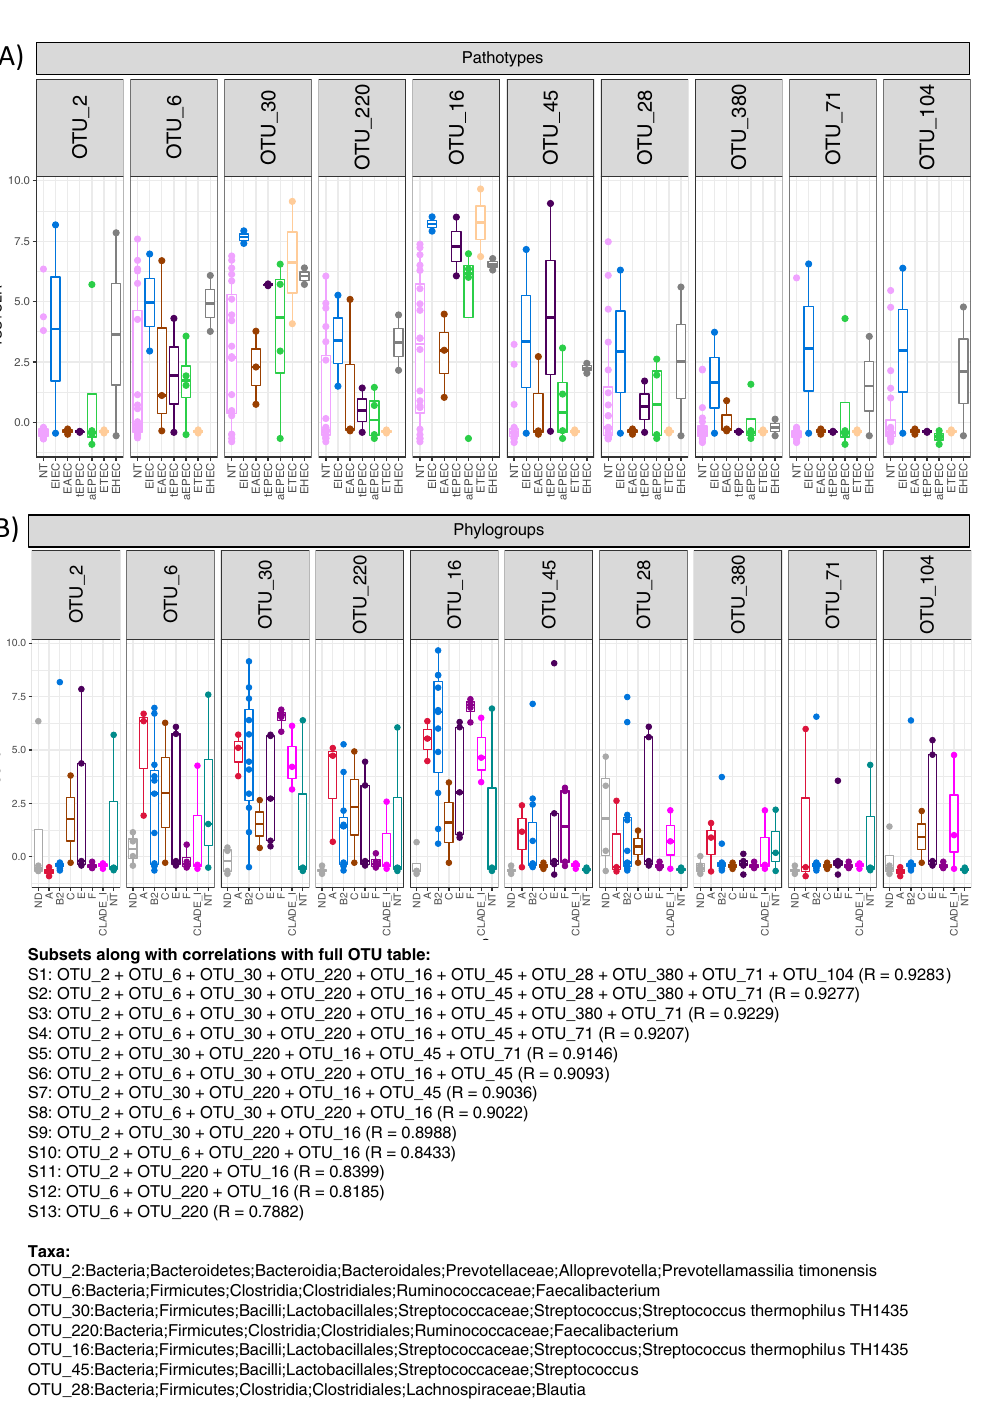
Figure 4. Expression of significant OTUs identified from the BVSTEP routine with samples organized under a given convention, whether it is pathotypes ( A ) or phylogroups ( B ). The information, and the taxonomy of OTUs from the top subsets is given below the figure with the correlation between Bray–Curtis distances between a particular subset and the full OTU table given in